Question: Based on the figure, does the quantity rise or fall?
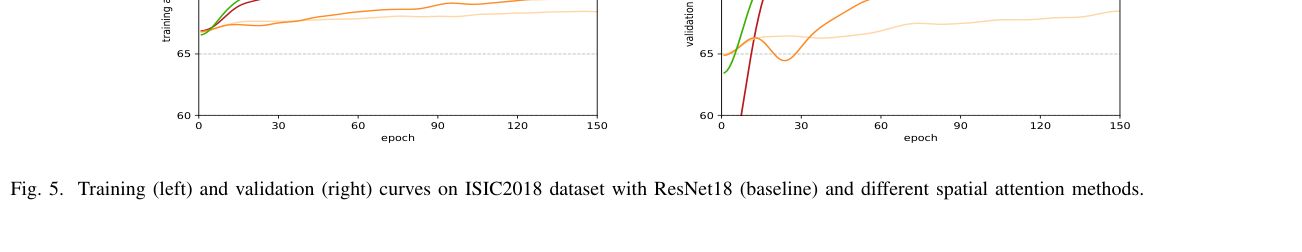
Answer: increasing